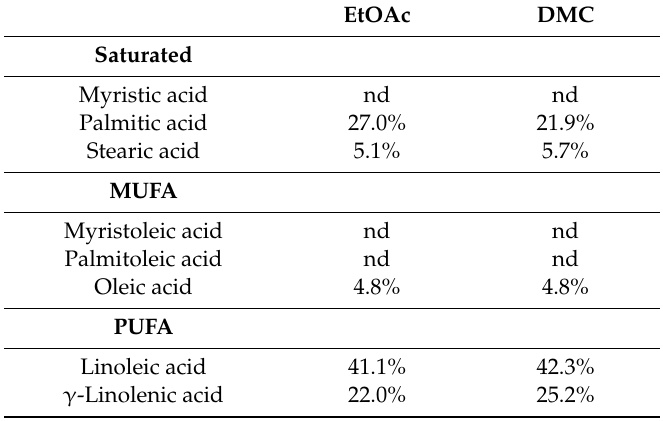
Table 2. Free fatty acid (FFA) ratios in A. platensis extracts, in relative percentage of total FFA.